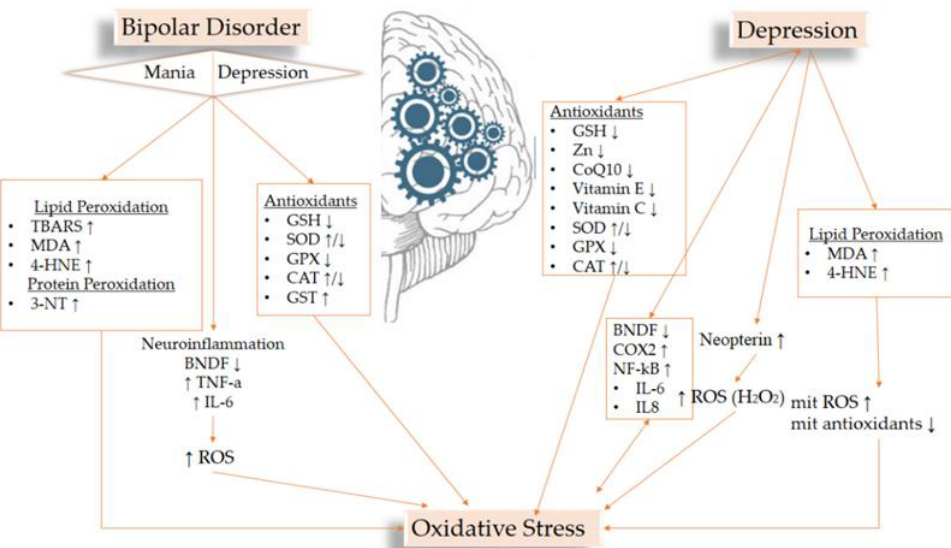
Figure 1. Flowchart of the most important results related to OS biomarkers and the studied disorders. Table 1 summarize the OS biomarkers used in various studies studying